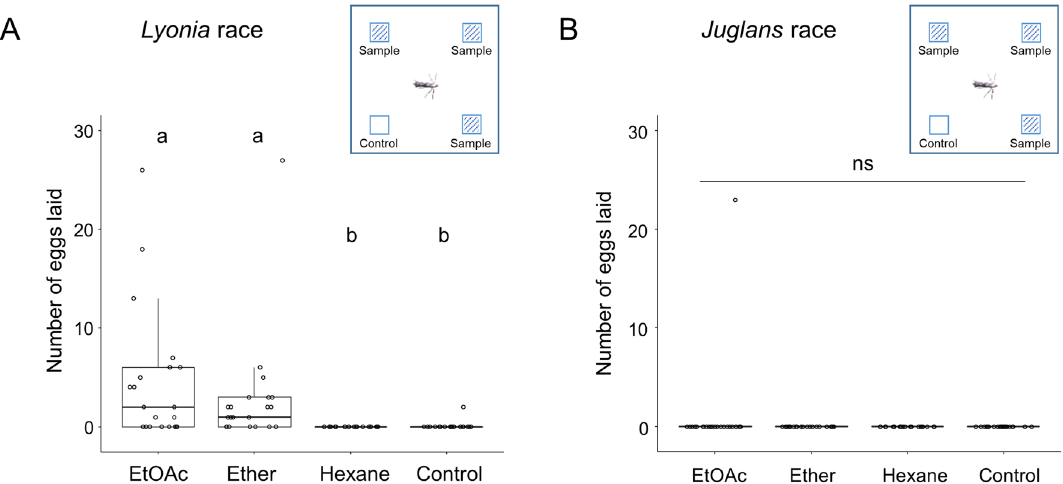
Figure 2. Oviposition responses of Lyonia and Juglans race females to leaf extracts of Lyonia ovalifolia . ( A ) Number of eggs laid by Lyonia race females on cover glasses treated with or without leaf extract using different solvents in four-choice assays. Different letters indicate statistically significant differences among the treatments by Steel–Dwass test, * p < 0.01 ( n = 21). ( B ) Oviposition responses of Juglans race females on cover glasses treated with or without leaf extract using different solvents in four-choice assays. No significant difference was observed among the treatments by Steel–Dwass test ( n =